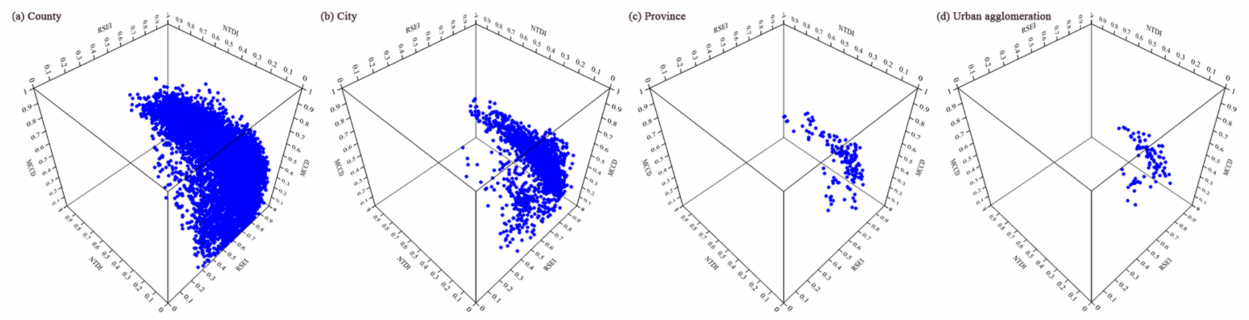
Figure 9. Three-dimensional diagrams of the RSEI, NTDI and MCCD at different scales.